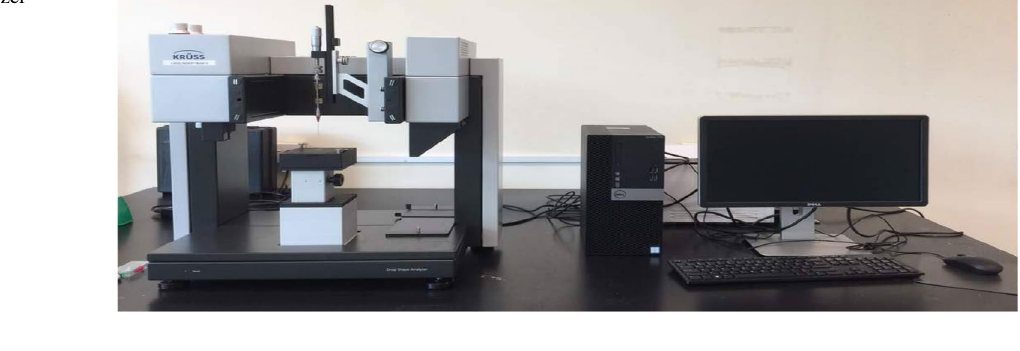
Fig. 6 Drop Shape Analyzer